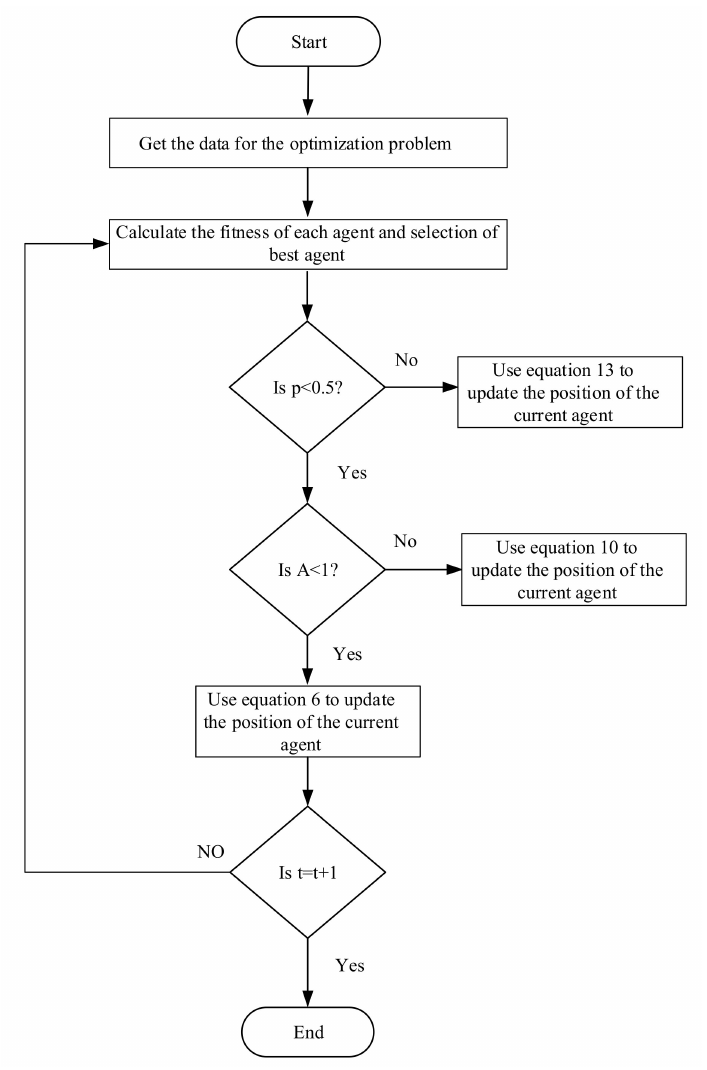
Figure 2. The flowchart of whale optimization algorithm